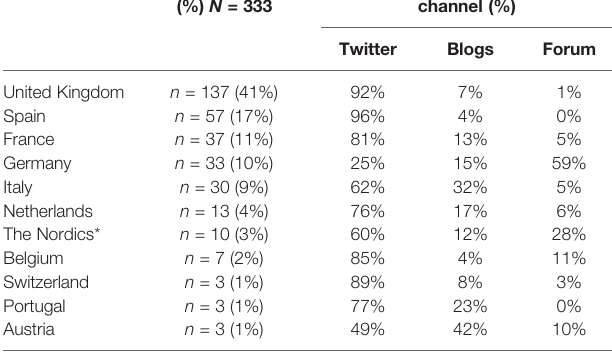
Table 2 highlights key country-speci fi c metrics.